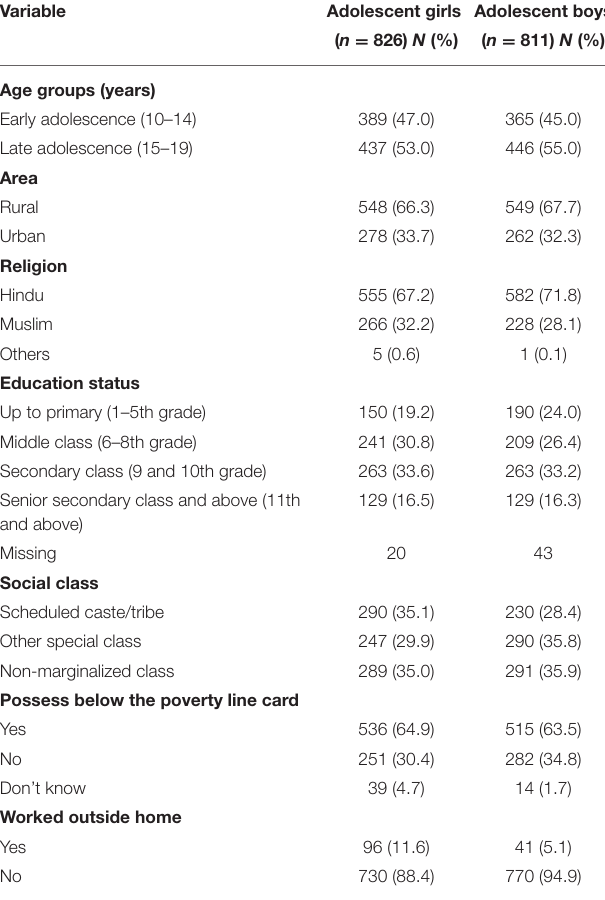
TABLE 1 | Percent distribution of adolescent boys and girls with respect to selected background characteristics in two districts of Bihar and